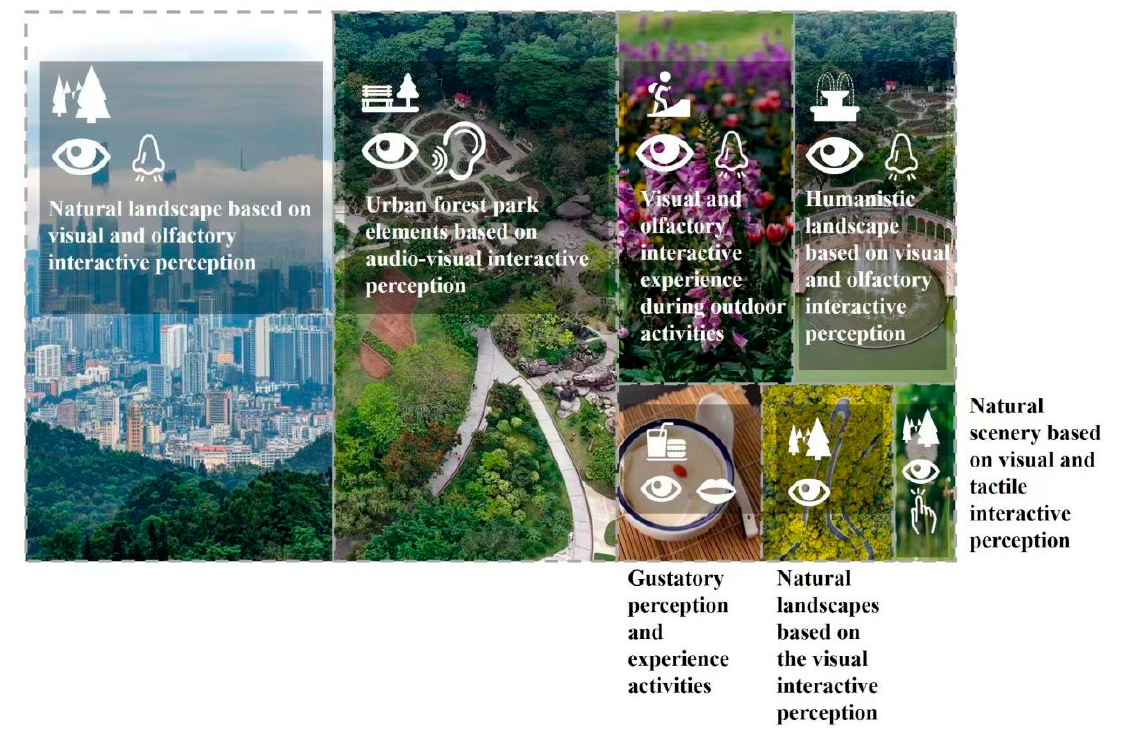
Figure 14. Tree diagram of the share of each cluster.